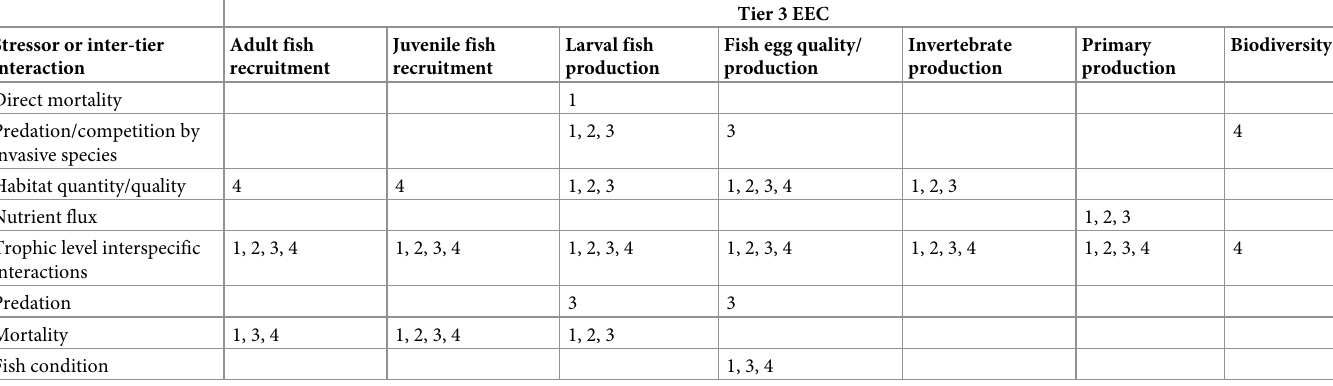
Table 3. Stressors or inter-tier interactions affecting Tier 3 Essential Ecosystem Characteristics (EEC) identified in the application of the conceptual model to case studies in the Canadian River (1), Colorado River (2), Columbia River (3), and Upper Mississippi and Illinois rivers